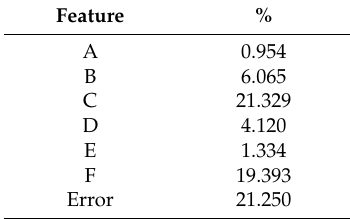
Table 4. Error reported by the ANOVA analysis and relative influence of the election of the input features on the global result when the k -Nearest Neighbor ( k -NN) algorithm is applied.